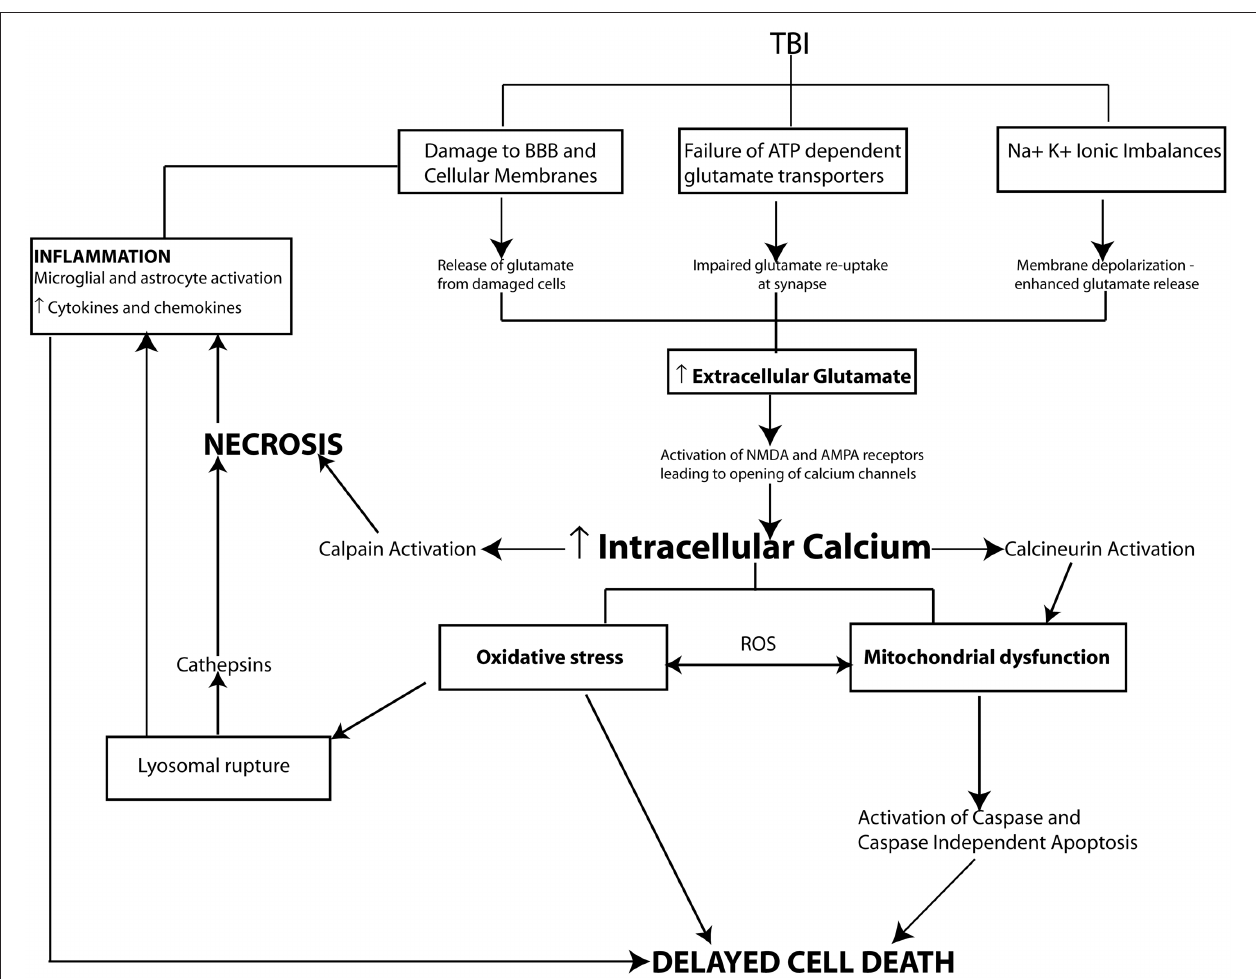
FIGURE 2 | Pathophysiological mechanisms of cell death following TBI. In moderate to severe cases of TBI the extent of cell death strongly correlates with cognitive outcome. Following injury cell death can occur by two main pathways, necrosis and programmed cell death. Necrotic cell death is a rapid uncontrolled form of cell loss mediated primarily by calpains and spilled lysosomal cathepsins and contributes to the inflammatory response following TBI. In comparison programmed cell death mechanisms including apoptosis, necroptosis or autophagy occur in a delayed fashion following TBI. A key initiating event in the cell